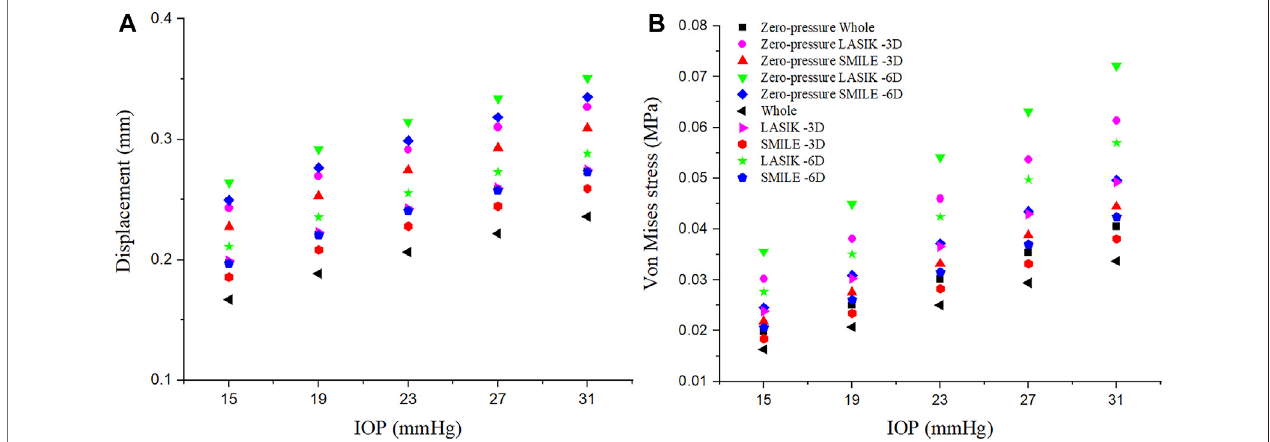
FIGURE 7 | Effects of the IOP on the displacement and Von Mises stress of the corneal residual stromal bed vertex. The IOP was set at 15 mmHg, 19 mmHg, 23 mmHg, 27 mmHg, and 31 mmHg, respectively. (A) Displacement. (B) Von Mises stress.